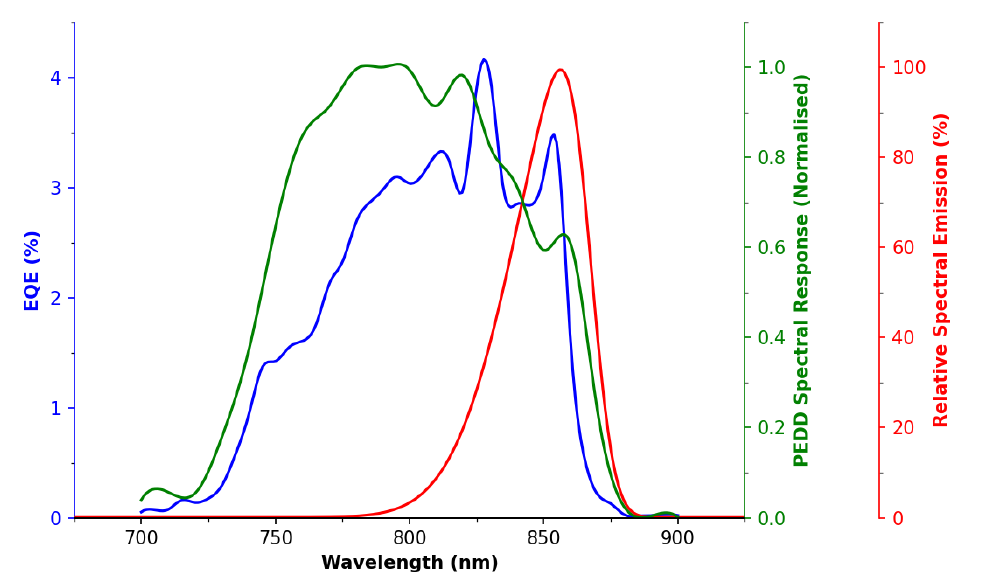
Figure 3. Spectral sensitivity and emission of the LED from 700–900 nm. EQE response (blue line), PEDD in measurement mode (green line) and LED emission spectra (red